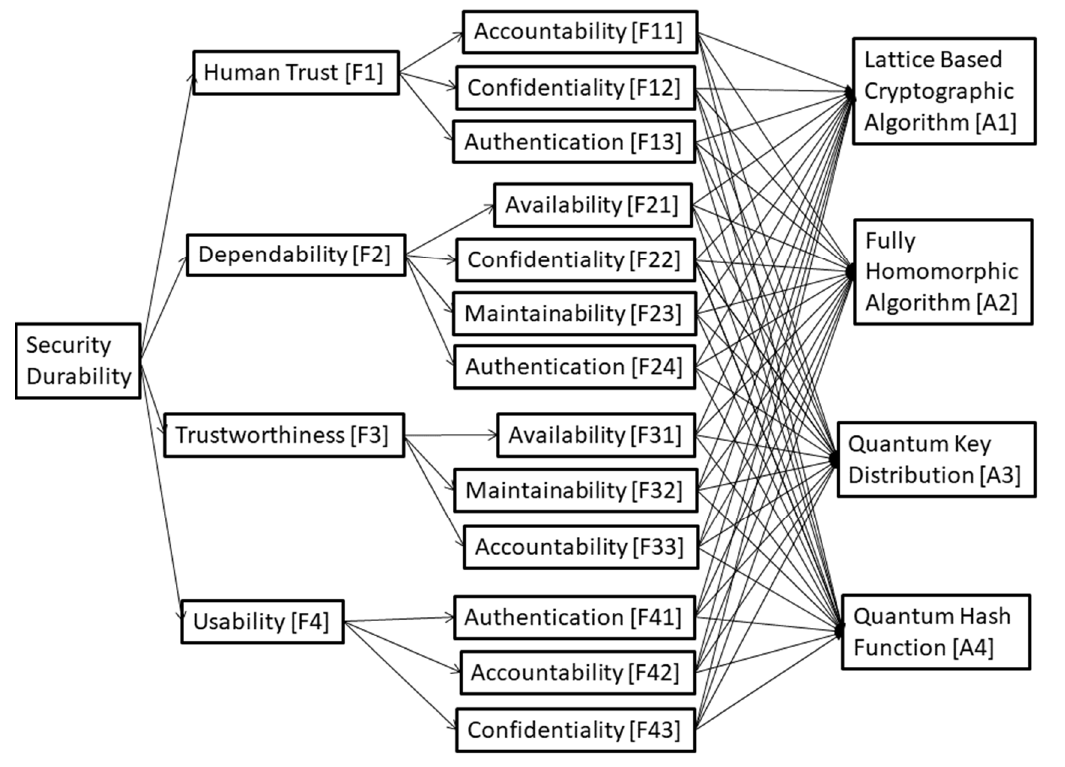
Figure 1. Schematic diagram of software durability factors and quantum security alternatives.